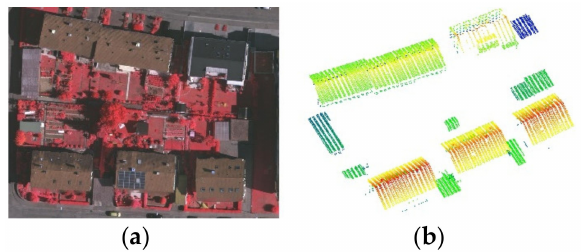
Figure 4. Residential area with detached houses: ( a ) aerial image corresponding to a residential area with detached houses; ( b ) residential area with detached houses point